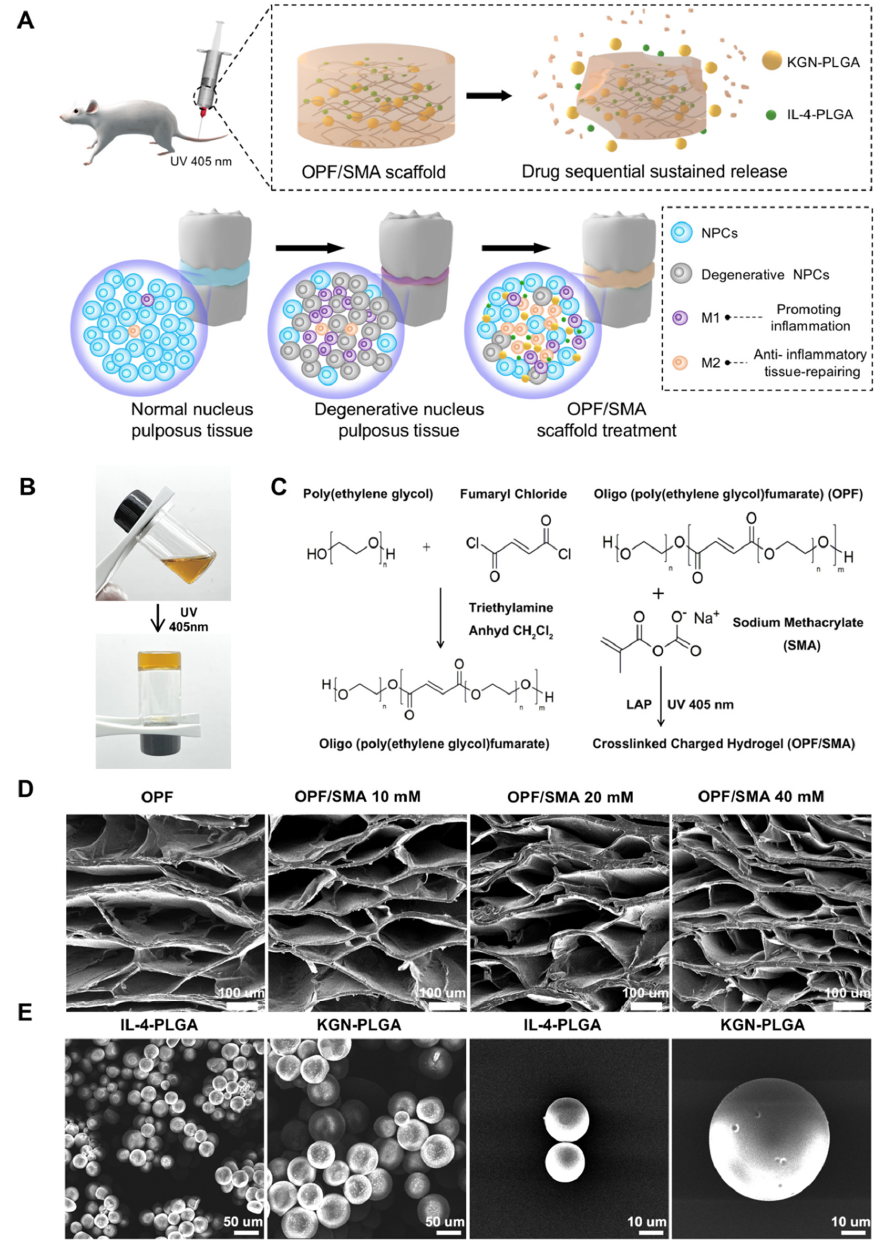
Figure 1. Synthesis and characterization of OPF/SMA hydrogel scaffolds and PLGA microspheres. ( A ) Schematic diagram of OPF/SMA hydrogel scaffold loaded with double-drug-loaded microspheres to regulate the microenvironment of intervertebral disc inflammation. ( B ) After the precursor solution of OPF/SMA was irradiated by ultraviolet light of 405 nm for 20 s, the carbon–carbon double bond broke and then reconnected to form a hydrogel. ( C ) Schematic diagram of chemical crosslinking of OPF/SMA hydrogel scaffolds. ( D , E ). Scanning electron microscope (SEM) imaging of OPF/SMA, IL-4-PLGA, and KGN-PLGA. The surface of the samples was sputter-coated with gold and palladium for 60 s and then detected at 5 kV accelerating voltage.